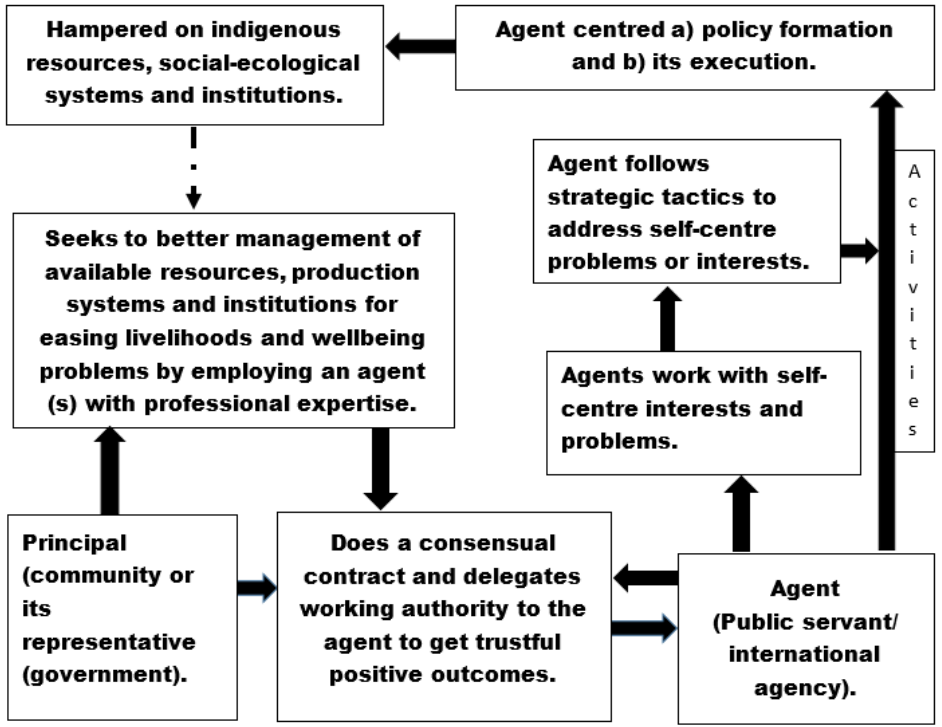
Figure 1. A conceptual principal-agent model that results in loss of indigenous resources, social- ecological systems, and institutions by interventions of external supporting agencies.